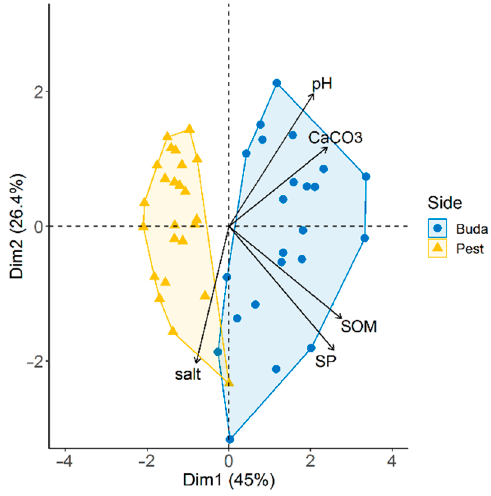
Figure 5. Principal component analysis (PCA) biplot of the sample sites according to the studied edaphic factors. Abbreviations: SOM, soil organic matter; SP, saturation percentage. Table 3. Results of the general linear mixed models showing significant relationships between functional trait levels and edaphic factors. SOM: soil organic matter.